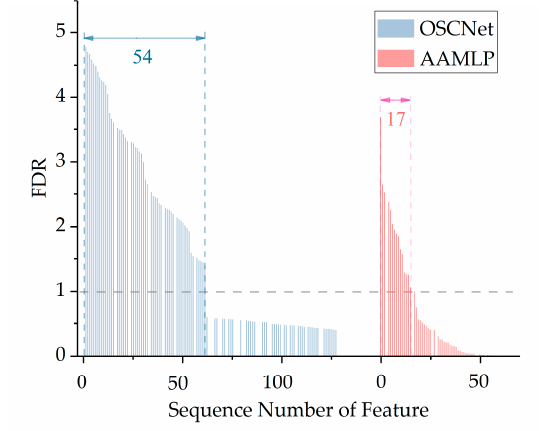
Figure 15. Fisher’s Discriminant Ratios (FDRs) of the features. The blue part (left) represents OSCNet and the red part (right) represents AAMLP. The gaps in the features are those removed for similar features. The number of valid features with FDR > 1 is 54 and 17 for OSCNet and AAMLP, respectively.